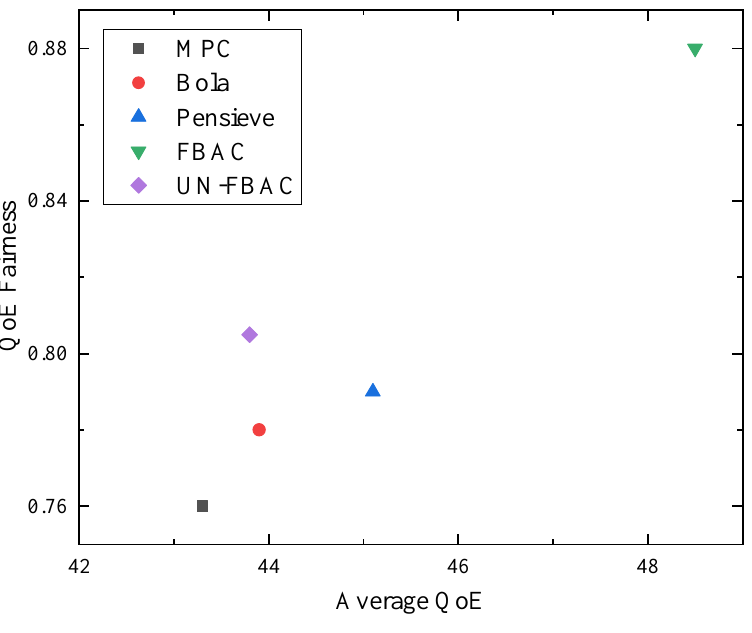
Figure 7. Main experimental results under dynamic